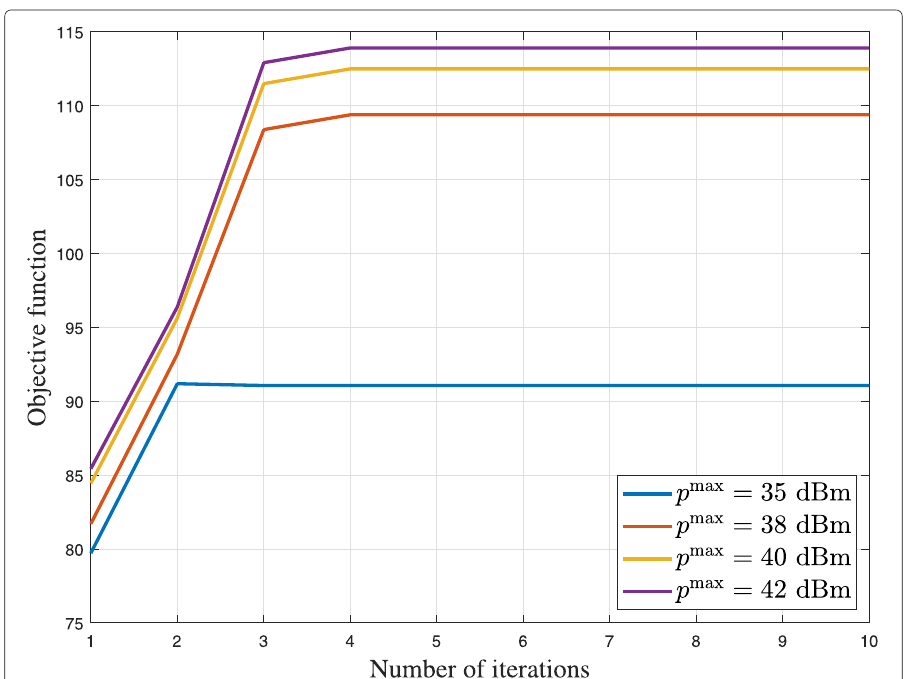
Fig. 5 The convergence behavior analysis of Algorithm 3 under the different maximum transmit power of BSs